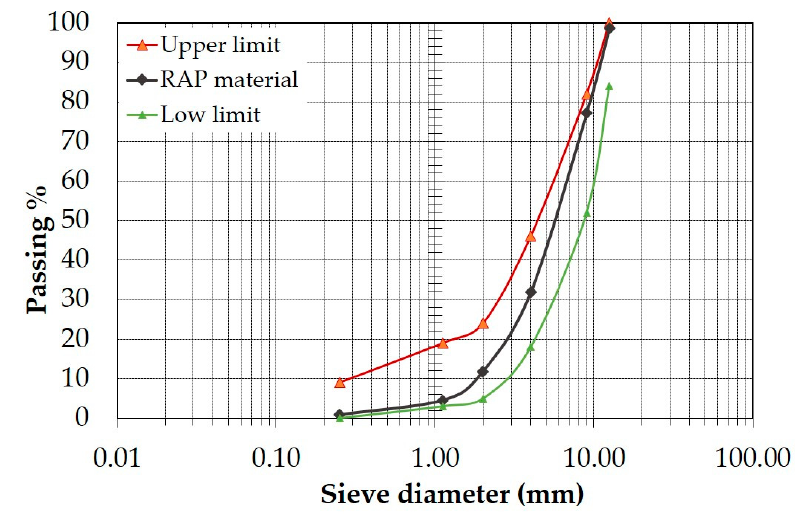
Figure 6. RAP gradation. Table 2. The volumetric properties of all fabricated HMA-RAP specimens.